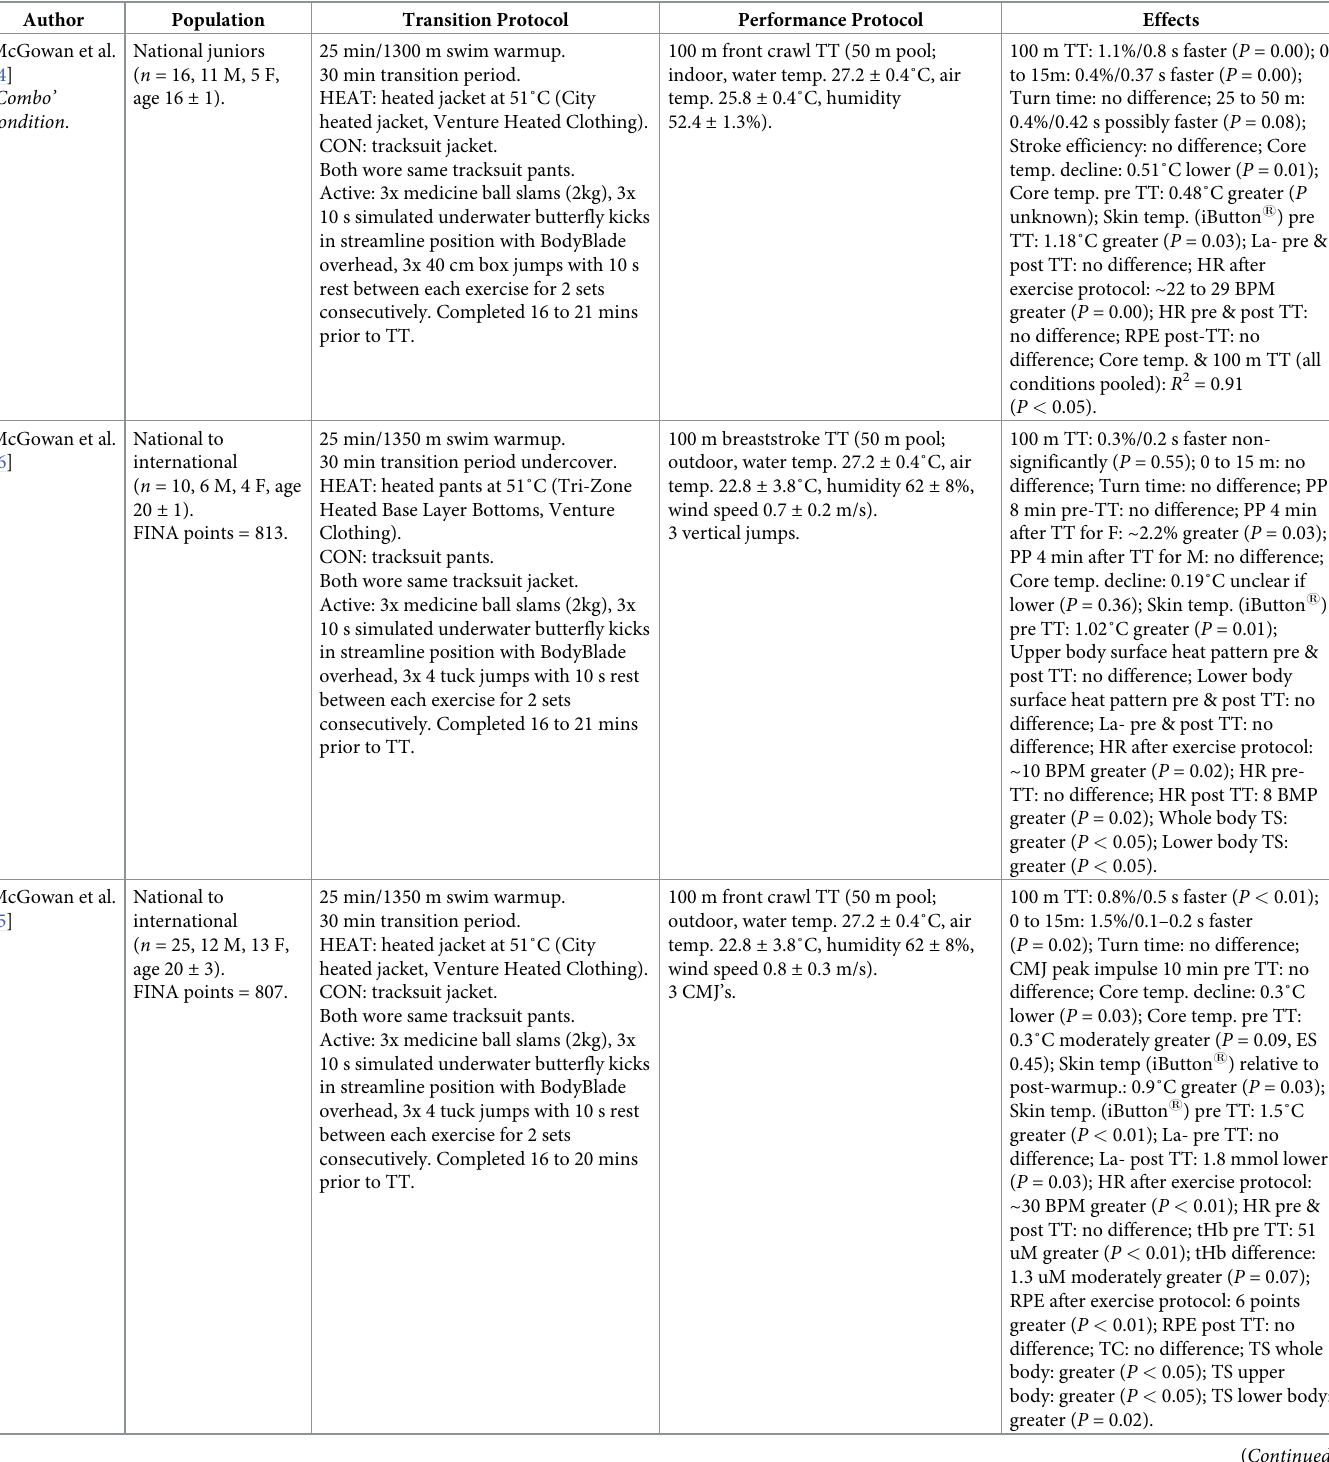
Table 5. Combination